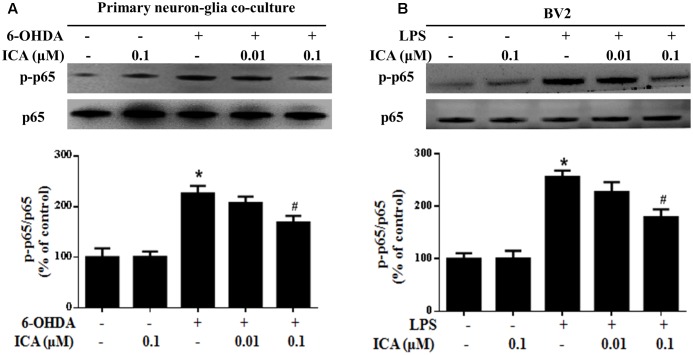
Icariin attenuated LPS-/6-OHDA-induced NF-κB signaling pathway activation in vitro. Primary neuron-glia cultures (A) and BV2 cell line (B) were treated with ICA for 30 min and then stimulated with 6-OHDA or LPS for 24 h. The protein expressions of phosphorylated p65 (p-p65) and p65 were investigated by western blot analysis. The ratio of densitometry values of p-p65 with total p65 was analyzed and normalized to each respective control group. Results were the mean ± SEM from three independent experiments performed in triplicate. ∗p < 0.05 compared with the control cultures; #p < 0.05 compared with 6-OHDA/LPS-treated cultures.